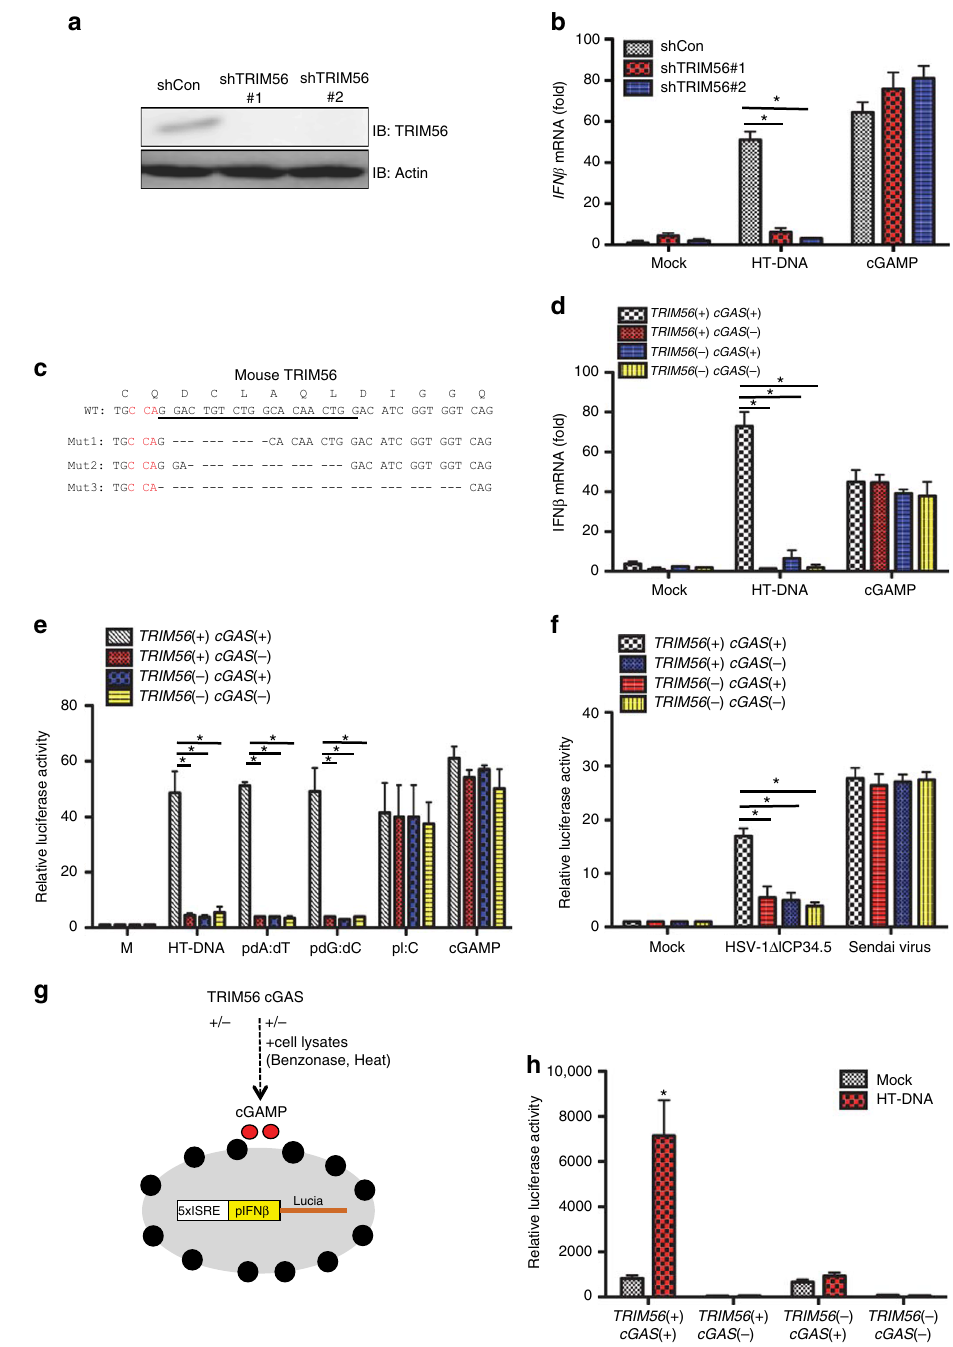
Fig. 2 TRIM56 is required for cGAS-dependent signal transduction and acts upstream of STING. a THP-1 cells were stably transfected with control shRNA, TRIM56#1 shRNA, or TRIM56#2 shRNA. Cell lysates were detected with the indicated antibodies. b THP-1 cells used in a were stimulated with HT-DNA (2 μ g/ml) and cGAMP (3 μ g/ml). The expression of IFN β mRNA was measured using real-time PCR. c Generation of TRIM56 − / − L929 cells. CRISPR-Cas9 targeting: the CRISPR target site in exon 1 of TRIM56 is underlined, and the protospacer adjacent motif (PAM) is shown in red. Deletions in the three TRIM56 alleles, each of which results in a frameshift, are shown by the black dashes. d cGAS-deleted L929 cells with or without TRIM56 deletion were complemented with wild-type cGAS-FLAG and stimulated with HT-DNA (2 μ g/ml) and cGAMP (3 μ g/ml). The expression of IFN β mRNA was measured using real-time PCR. e L929 cell lines used in d were stably transfected with ISREIFN β -Lucia reporter genes. Cells were stimulated with HT-DNA (2 μ g/ml), poly dA:dT (1 μ g/ml), poly dG:dC (1 μ g/ml) polyI:C (1 μ g/ml), and cGAMP (3 μ g/ml). Luciferase activity was measured 18 h after stimulation. f L929 cell lines used in e were infected with HSV-1 Δ ICP34.5 (MOI = 5) and Sendai virus. Luciferase activity was measured 18 h after stimulation. g Schematic representation of the cGAMP bio-assay. Relative cGAMP activity was measured using THP1-Lucia ISG cells that generate luciferase in response to cGAMP. h cGAMP bio-assay. L929 cell lines used in d were stimulated with HT-DNA (2 μ g/ml) for 9 h. Extracts of the cells were prepared, DNase- and heat- treated, and incubated with permeabilized THP-1-Lucia ISG cells for 18 h. Relative luciferase activity was measured. Data in a , h are representative of two independent experiments. Data in b , d – f are representative of three independent experiments. Error bars in b , d – f , h indicate mean ± s.d. of n = 3 ( b , d – e ) and n = 2 ( f , h ). * P < 0.05, versus control using Student ’ s t -test ( b , d – f , h ). Full blots are shown in Supplementary Fig.